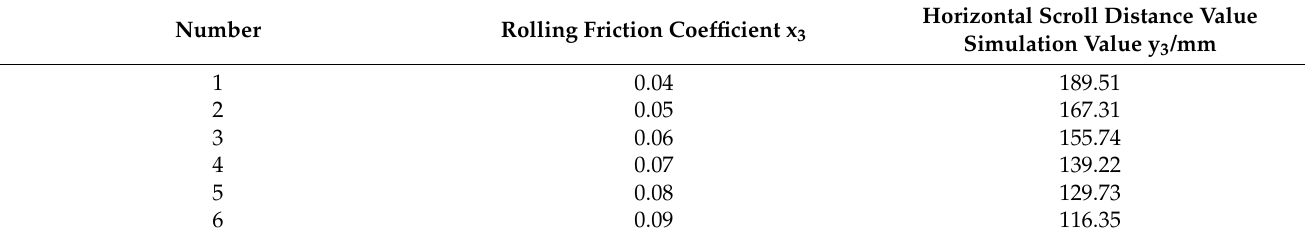
Table 5. Experimental scheme and results of rolling friction coefficient simulation experiment.